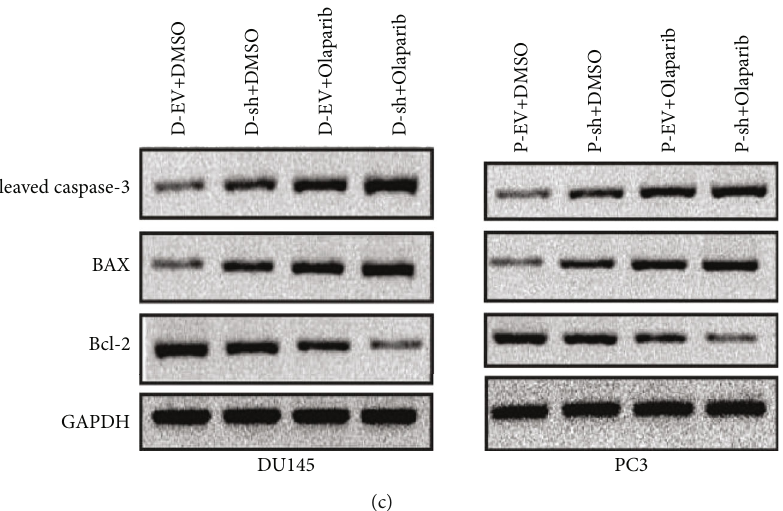
Figure 6: E ff ects of MUS81 silencing combined with Olaparib on apoptosis of CRPC cells. (a) Cell apoptosis of D: DU145, P: PC3.D-EV, D- sh, P-EV, and P-sh following 48 hours of either Olaparib or DMSO treatment by Annexin V-APC/7-AAD. (b) Apoptosis. (c) Expression of cleaved caspase-3, Bax, and Bcl-2 proteins in the CRPC cells by western blot. ∗∗∗ P < 0 : 001 .